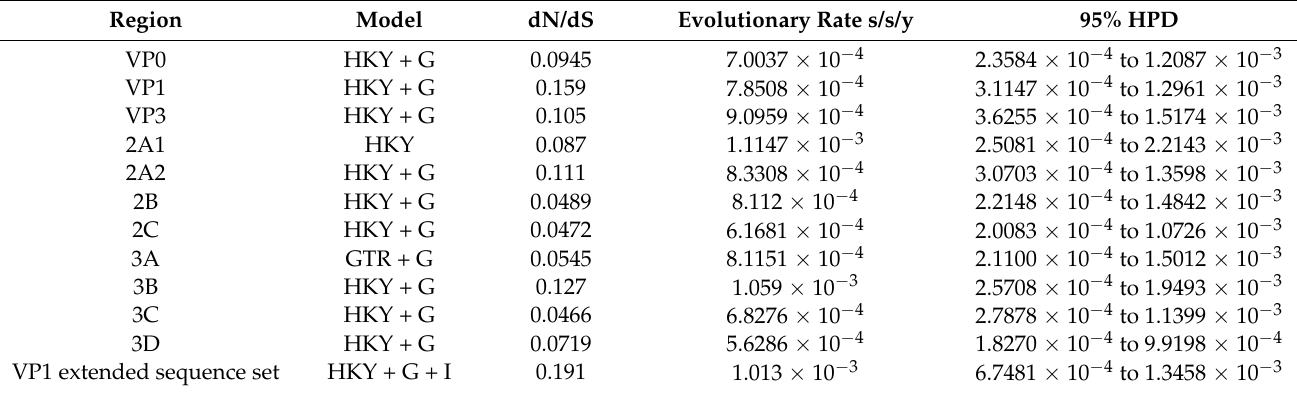
Table 3. The dN/dS ratios and evolutionary rates (substitutions/site/year) estimated for individual genes of DHAV-1.